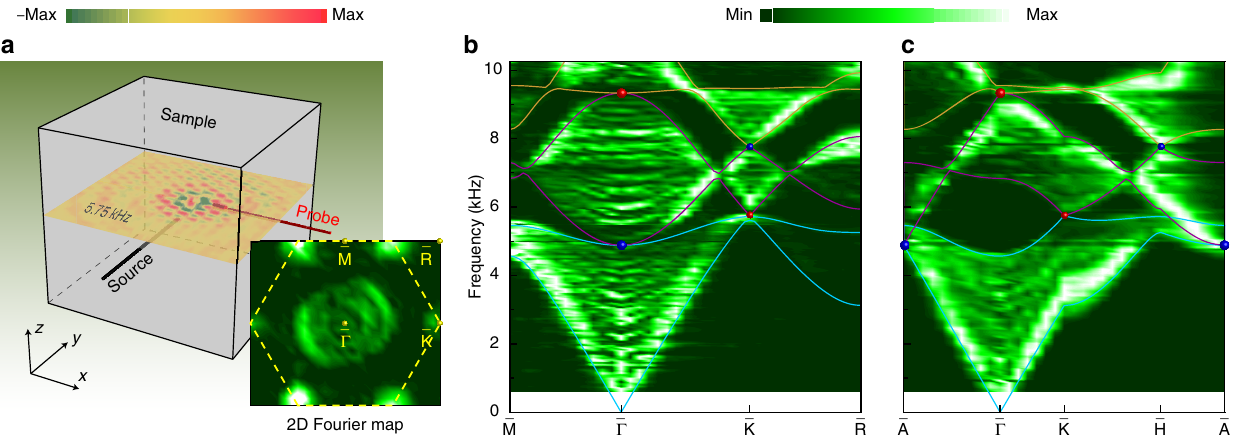
Fig. 2 Experimental evidence for the quadratic dispersions around QWPs. a Experimental setup. Inset: 2D Fourier transformation of the pressure fi eld measured in a horizontal xy plane inside the sample, exempli fi ed at the frequency (5.75 kHz) of the CWP at K . The dashed lines sketch the 2D projection of the bulk BZ. b Projected band structure (color scale) extracted along the high-symmetry lines. The color lines sketch the boundaries of the projected lowest three bulk bands simulated with COMSOL Multiphysics, and the color spheres highlight the projected Weyl nodes. c Similar to b , but for the 2D Fourier transformation of the pressure fi eld scanned in a vertical xz plane. The corresponding 2D projection of the bulk BZ is sketched in Fig.